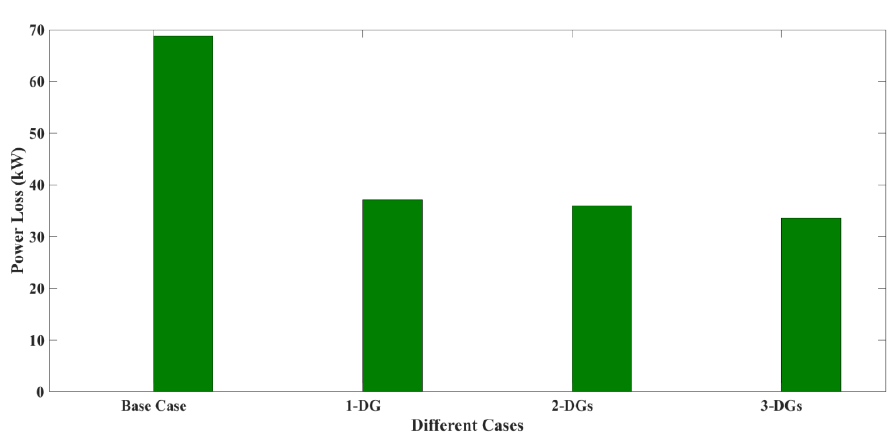
Figure 10. P Loss reduction for different Cases.